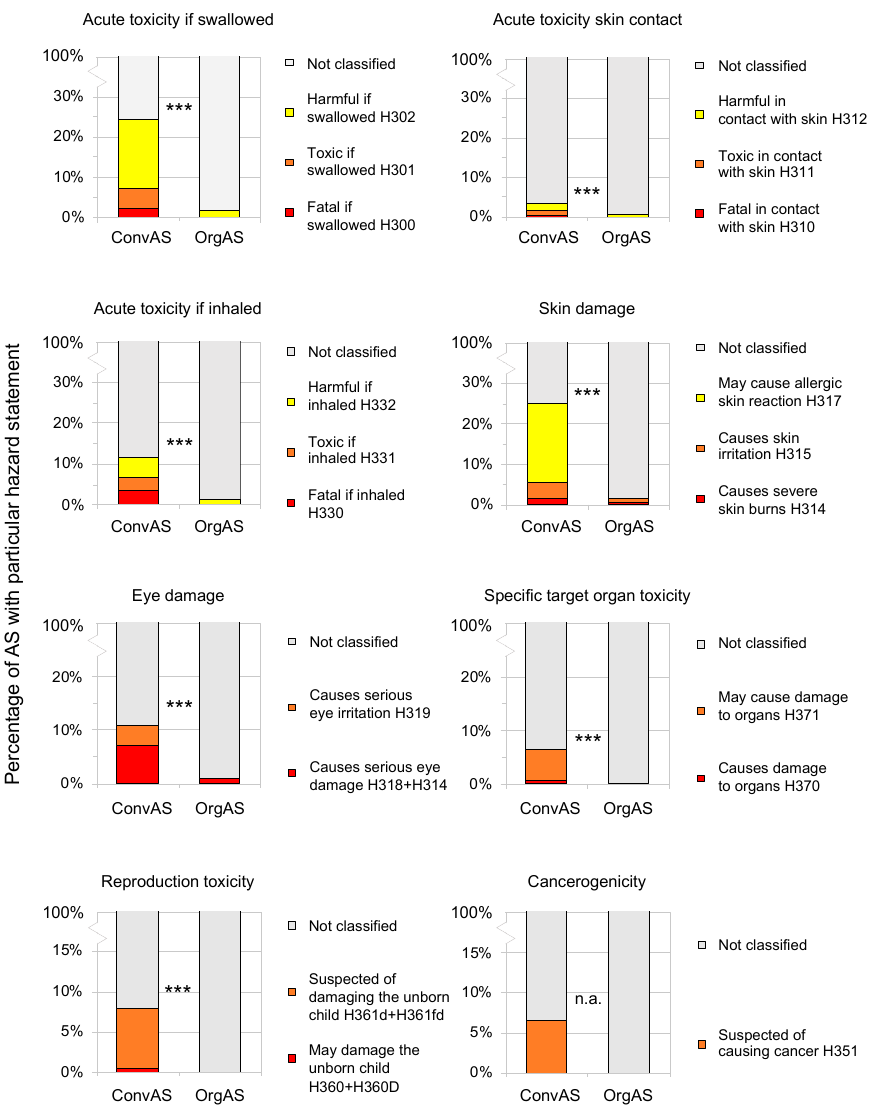
Figure 6. Comparison of human health-related hazard statements of active substances (AS) approved for use in conventional (ConvAS, n = 256) and organic agriculture (OrgAS, n = 134). Results of chi 2 tests denoted with asterisks: *** p < 0.001, n.a. … a chi 2 test was not applicable because of too few categories.